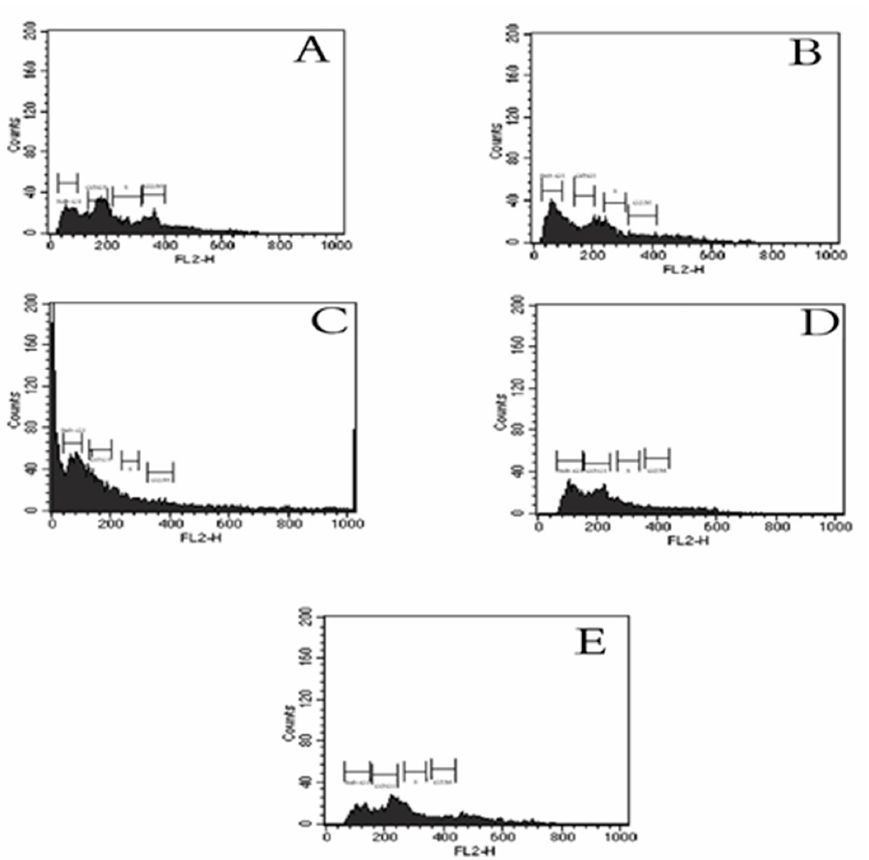
Figure 2. Flow-cytometric analysis of EAC cell cycle phase distribution. Cells from EAC bearing mice treated with 0.3 DMSO (positive control) and EAC bearing mice treated with 100 mg/kg for 5 constitutive days subcutaneously of indoloquinoline analogs 6a, 6b, 6c and 6d , fixed and nuclear DNA was labeled with PI. Cell cycle phase distribution of EAC nuclear DNA was determined by single label flow-cytometry. Histograms display of DNA content ( x -axis, PI-fluorescence) versus counts ( y -axis) showed ( A ) EAC of positive control, ( B ) EAC of 6a -treated EAC bearing mice, ( C ) EAC of 6b -treated EAC bearing mice, ( D ) EAC of 6c -treated EAC bearing mice; ( E ) EAC of 6d -treated EAC bearing mice.